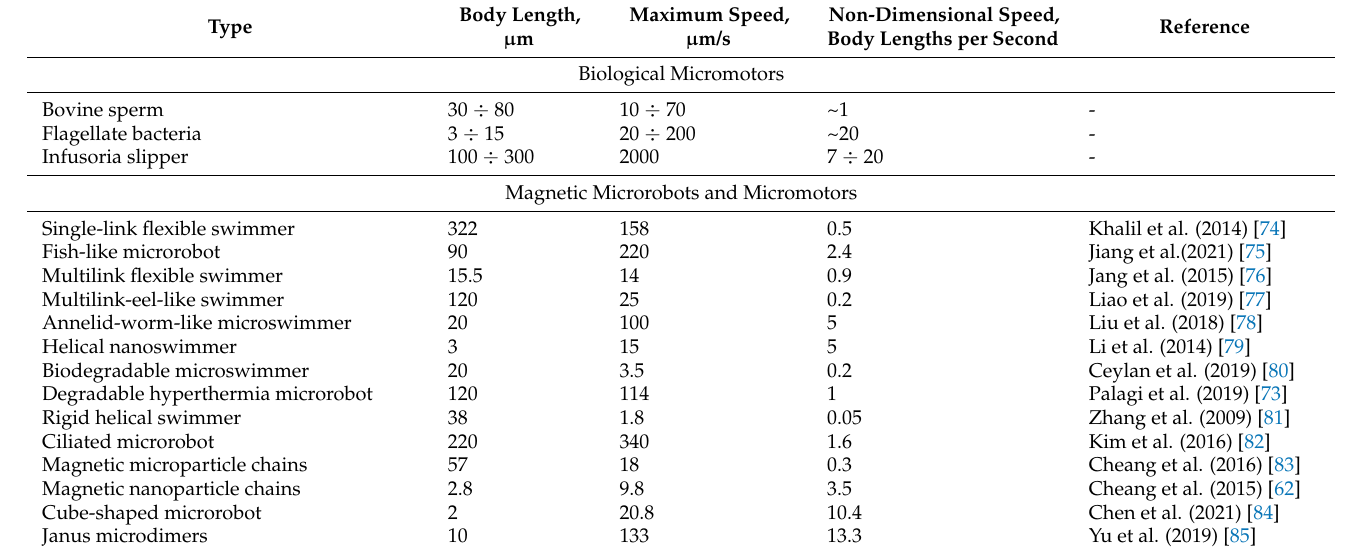
Table 1. Comparison of biological microorganisms and artificial bioinspired magnetic